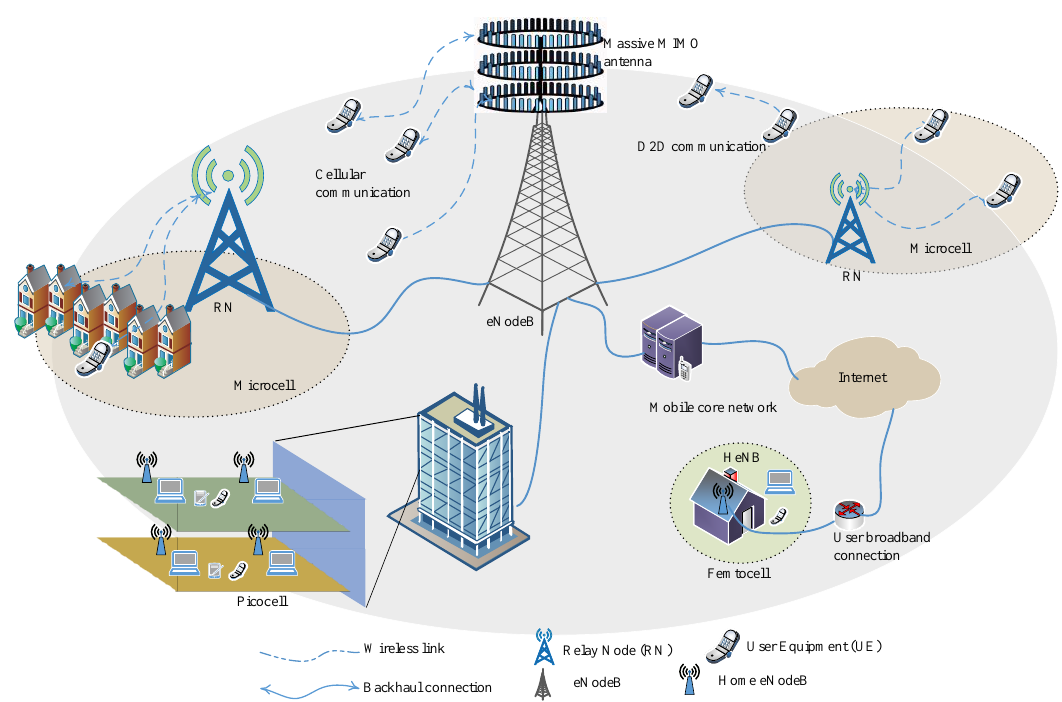
Figure 4. Small cell-based Heterogeneous Networks (HetNet).